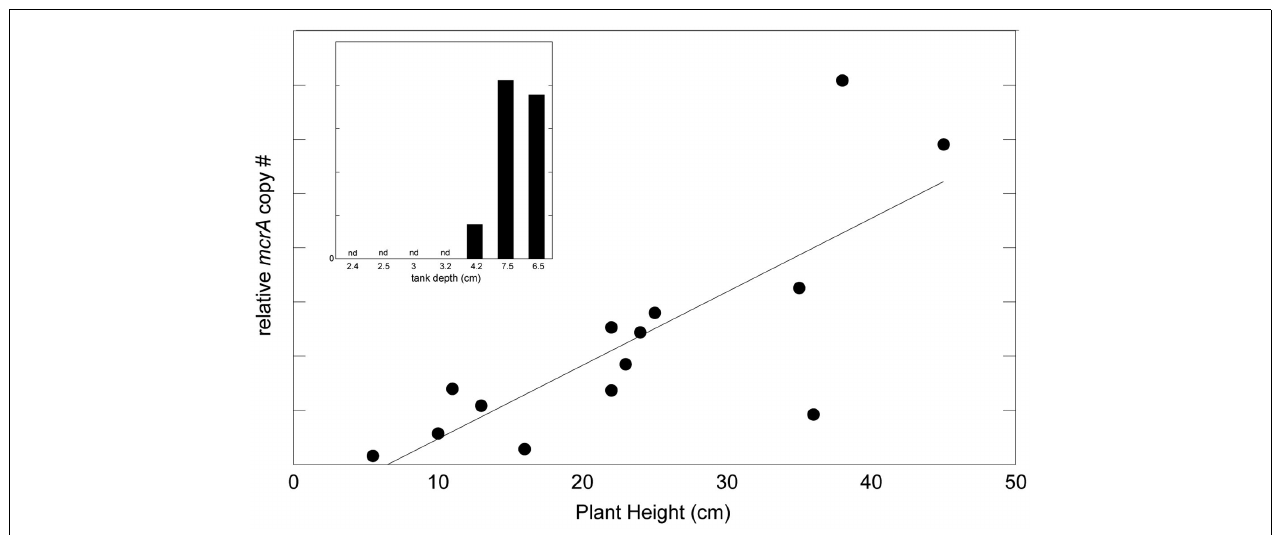
tanks. For seven clonal specimens of A. nudicaulis (connected via a rhizome and ranging from 2 to 7cm tank depth; 4–20cm estimated plant height), mcrA copy number revealed the same trend of increased relative copy # in larger plants, and no detection of mcrA genes in the smallest four individuals (inset). Note that actual mcrA copy numbers are not the focus and may have been affected (overestimated) by using plasmids as a QPCR standard.